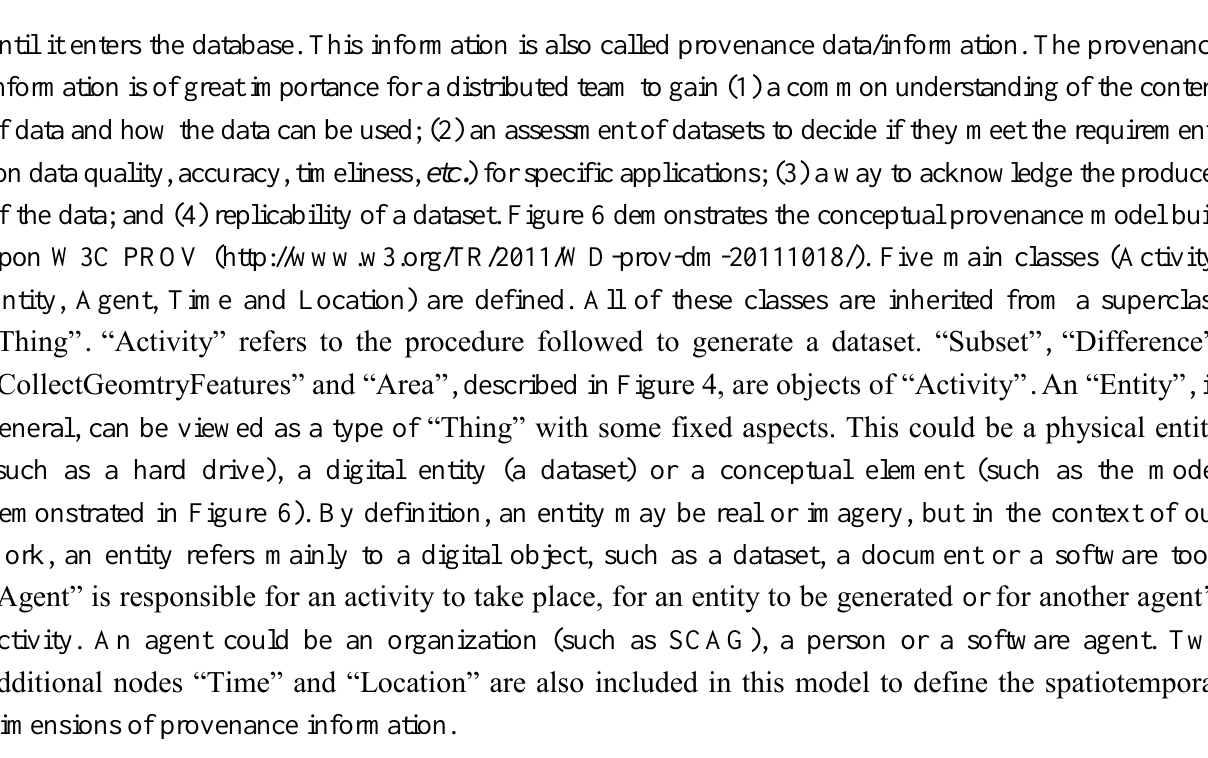
Figure 6. Conceptual model of W3C provenance